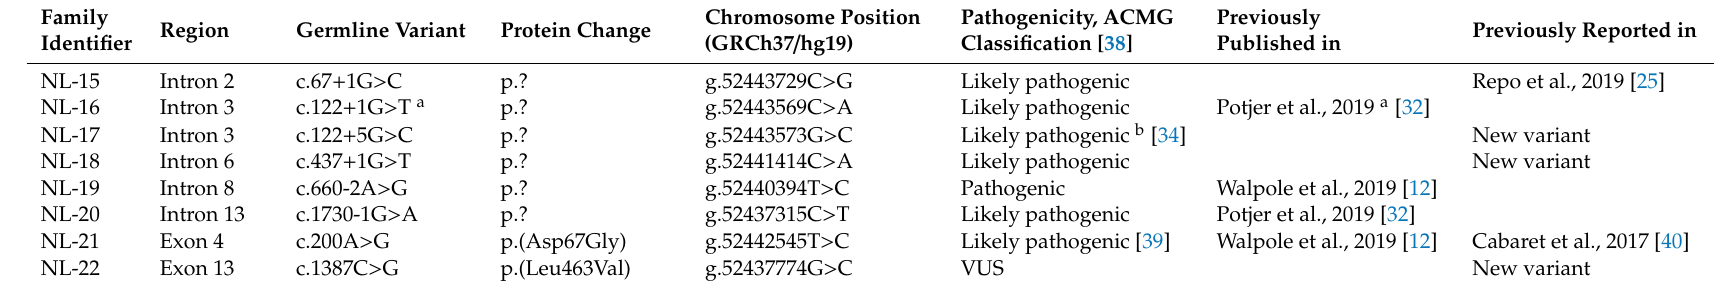
Table 3. Germline BAP1 variants in splice sites and missense